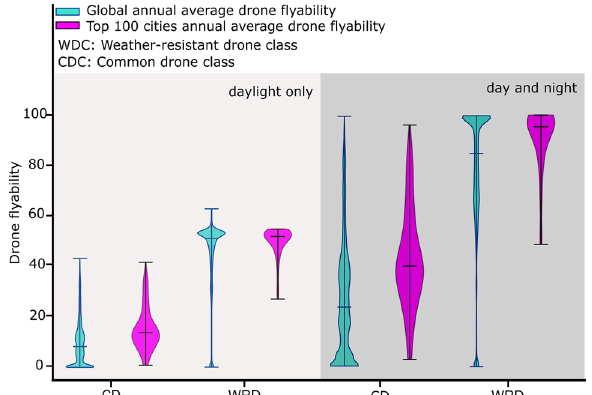
Figure 1. Violin plots of day-and-night and daylight-only flyability for CD and WRD. Cyan violins correspond to the distribution of flyabilities of CD and WRD globally and orange violins represent the distribution of flyabilities of CD and WRD from 100 most populated cities across the world 22 . The upper and lower hinges of violin plots indicate the minimum and maximum flyabilities. The horizontal bar of each violin represents the median of annual average drone